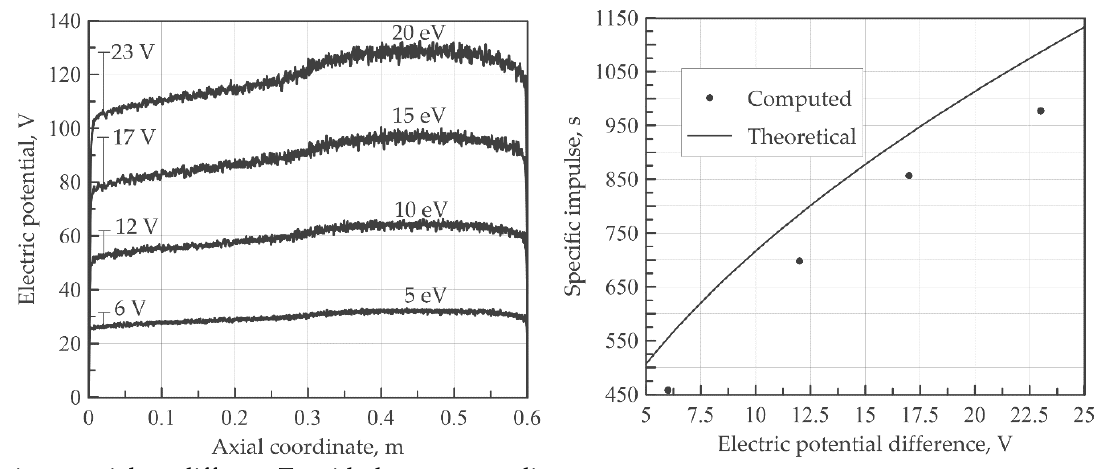
Figure 11. Effect of the electron temperature on the electric potential, potential drop, and the computed and the specific impulse at constant ionization rate 1 × 10 18 .